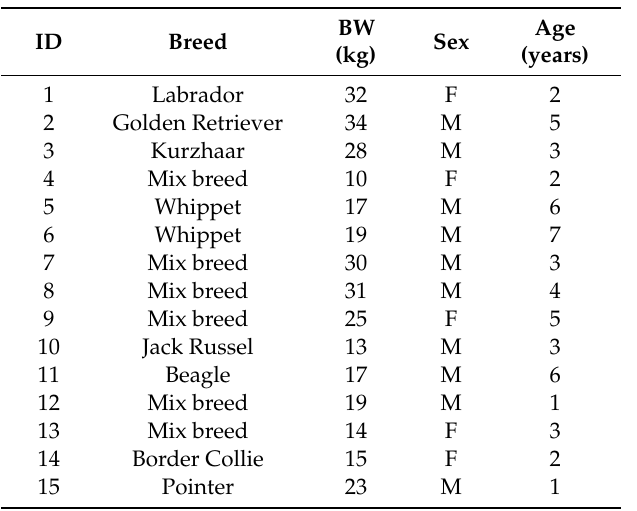
Table 1. Characteristics of the 15 dogs enrolled in the